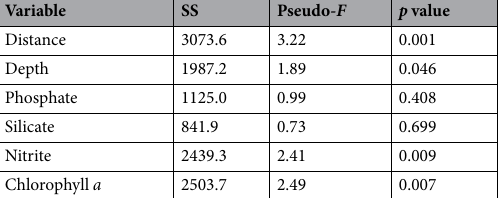
Table 5. Distance based linear modeling results based on coral reef survey benthic composition and associated environmental